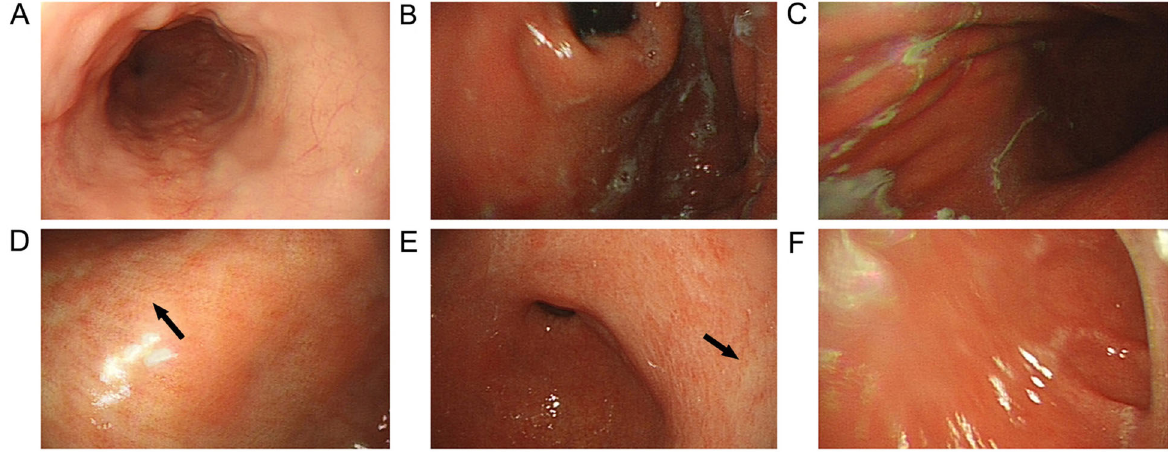
Figure 2. Gastroscopy images of chronic atrophic gastritis in Case 1. A , esophagus; B , gastric fundus; C , gastric body; D , gastric angular incisure; E , gastric antrum; F , duodenal bulb. The gastric mucosa at the atrophic site is red and white (arrows).